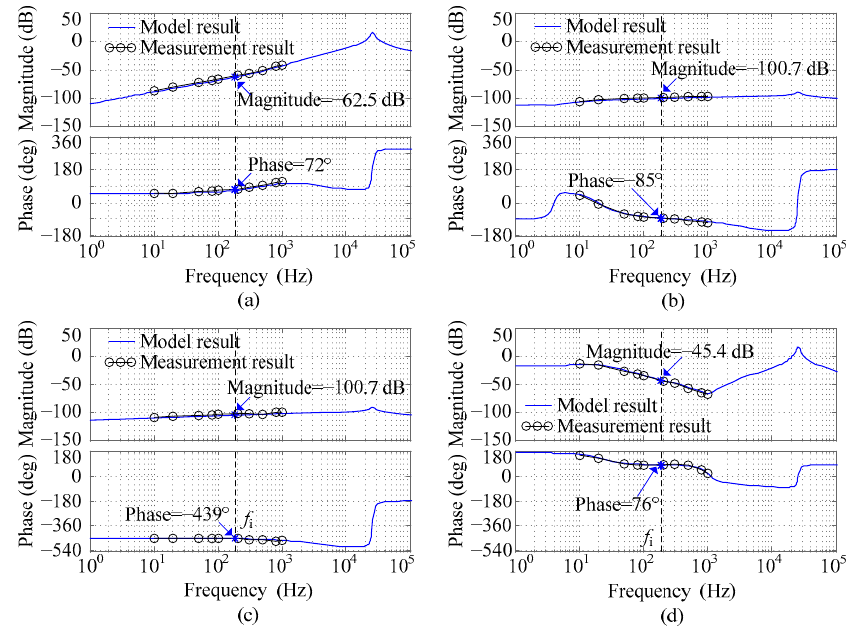
Figure 7. The Bode diagrams of inverter output admittance Y inv_PLL of traditional control method. ( a ) Y dd ; ( b ) Y qd ; ( c ) Y dq ; ( d ) Y qq .